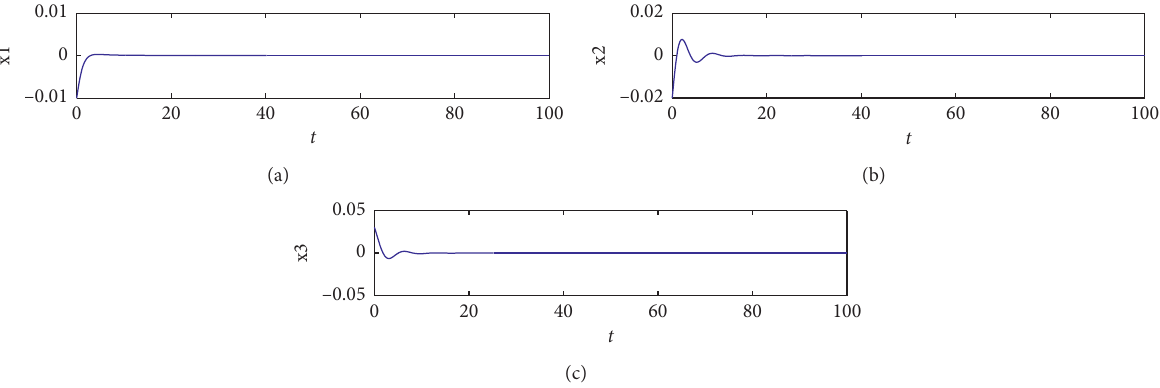
Figure 4: System (34) is asymptotically stable with α � 1.1.